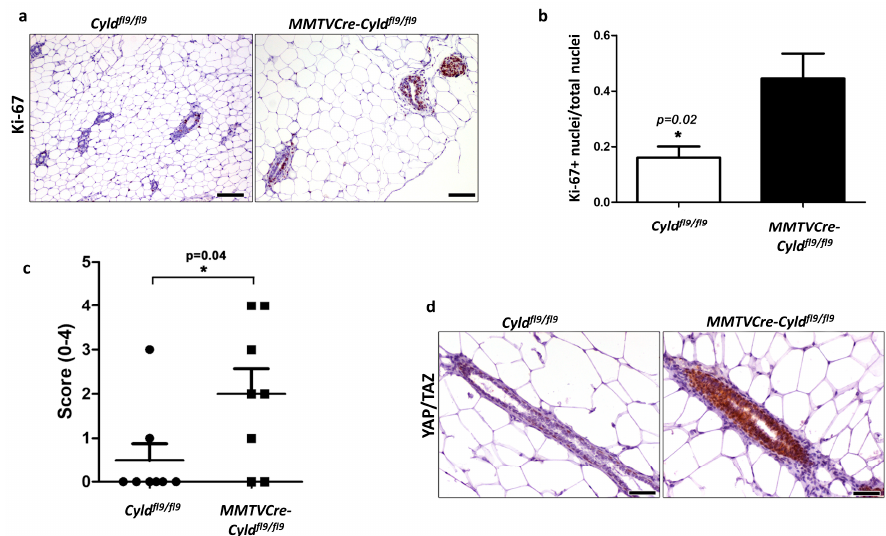
Figure 6. Immunohistochemical analysis of control and CYLD-deficient mouse mammary glands. ( a ) Comparison of Ki-67 expression in mammary epithelia of control ( Cyld fl9/fl9 ) and CYLD-deficient ( MMTVCre-Cyld fl9/fl9 ) mice. Bar = 100 μ M. ( b ) Quantitation of Ki-67 expression in mammary epithelia of control ( Cyld fl9/fl9 ) and CYLD-deficient ( MMTVCre-Cyld fl9/fl9 ) mice. ( c ) Hyperplasia was semi- quantitatively assessed in mammary gland sections from control and CYLD-deficient mice of a matched background (C57BL/6-BALB/c (1:1)) as described in the materials and methods. ( d ) Comparison of YAP/TAZ expression in mammary epithelia of control ( Cyld fl9/fl9 ) and CYLD-deficient ( MMTVCre-Cyld fl9/fl9 ) mice. Bar = 50 μ M. * p < 0.05.